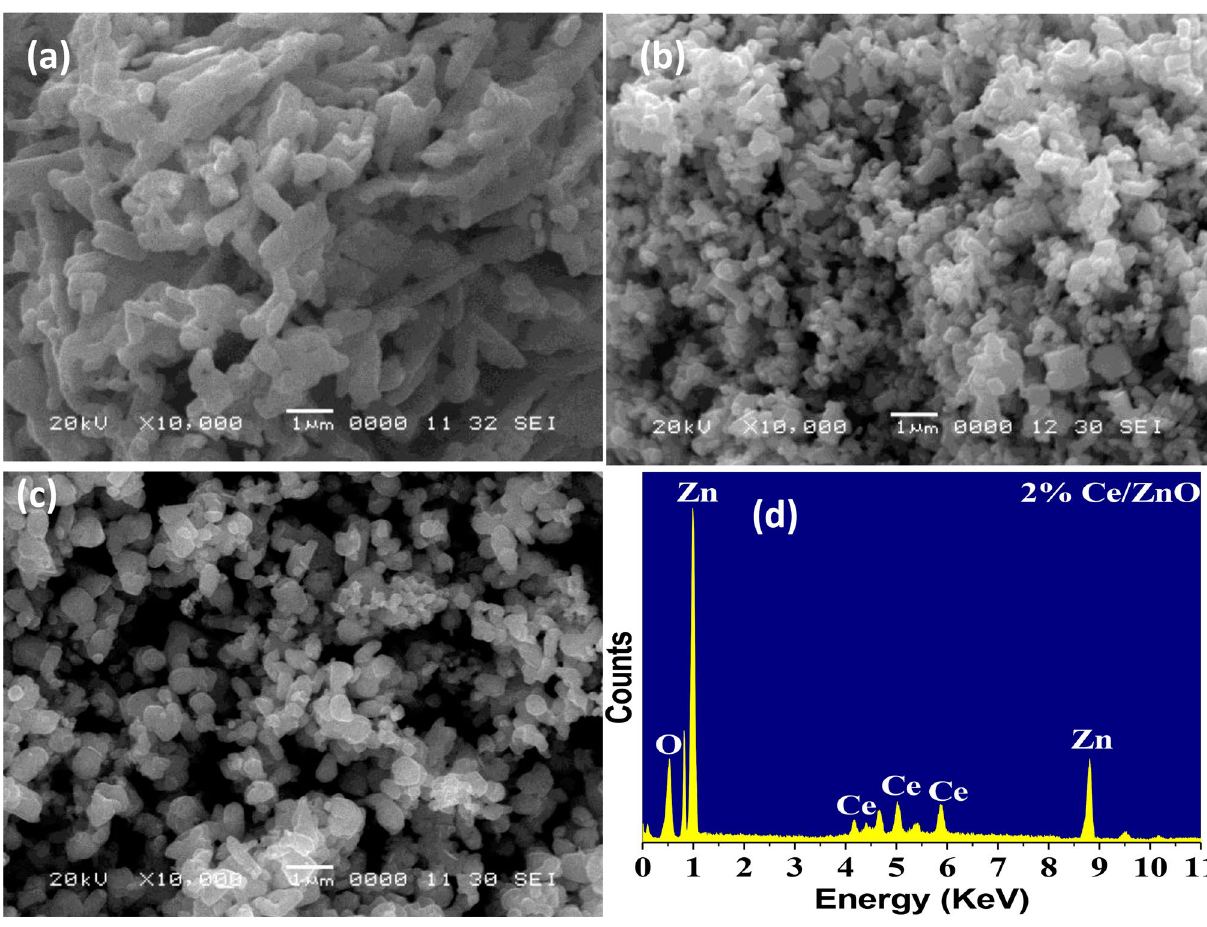
Fig. 7 SEM images of 2%Ce/ZnO calcined at a 500 °C, b 600 °C, c 700 °C, d EDX of 2%Ce/ZnO calcined at 600